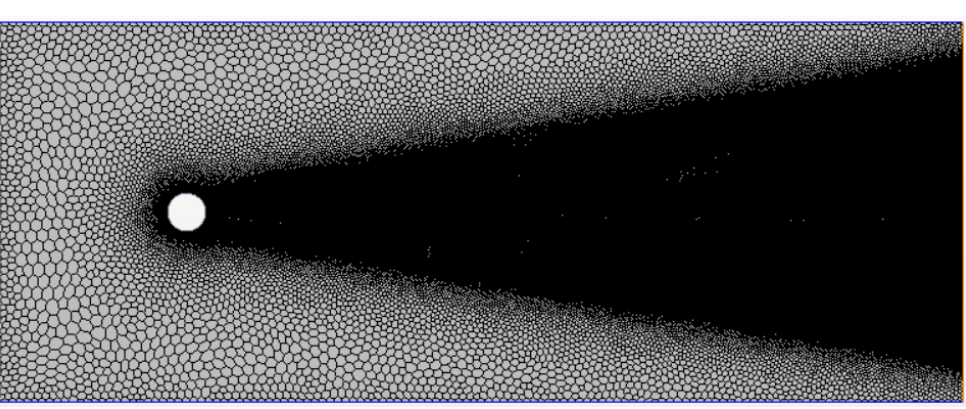
Figure 2. Mesh distribution around the cylinder.